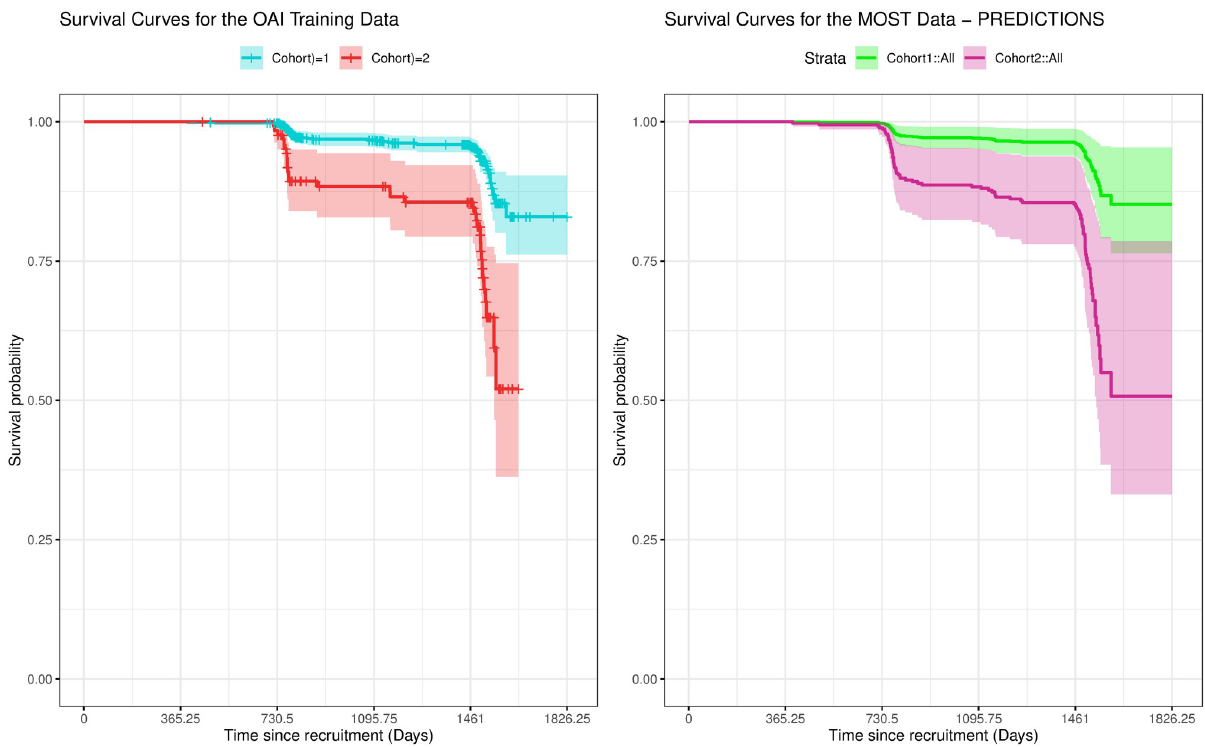
Fig 4. Risk stratification curves. Stratification curves on the left showing OAI training data showing the high and low risk cohorts. Note the last event recorded in cohort 2 within the 5-year span is at day 1642. The stratification curves on the right are the validation data showing the high and low risk cohorts fitted to the models developed using the OAI